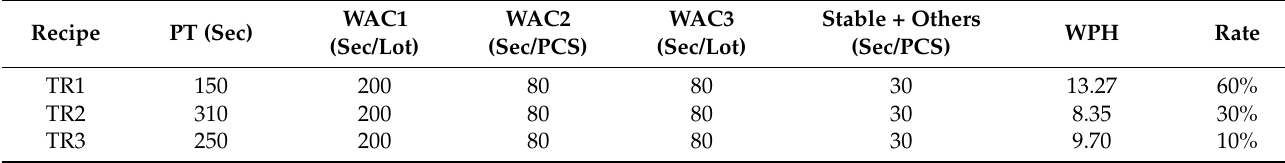
Table 1. Product mix and information of recipe.